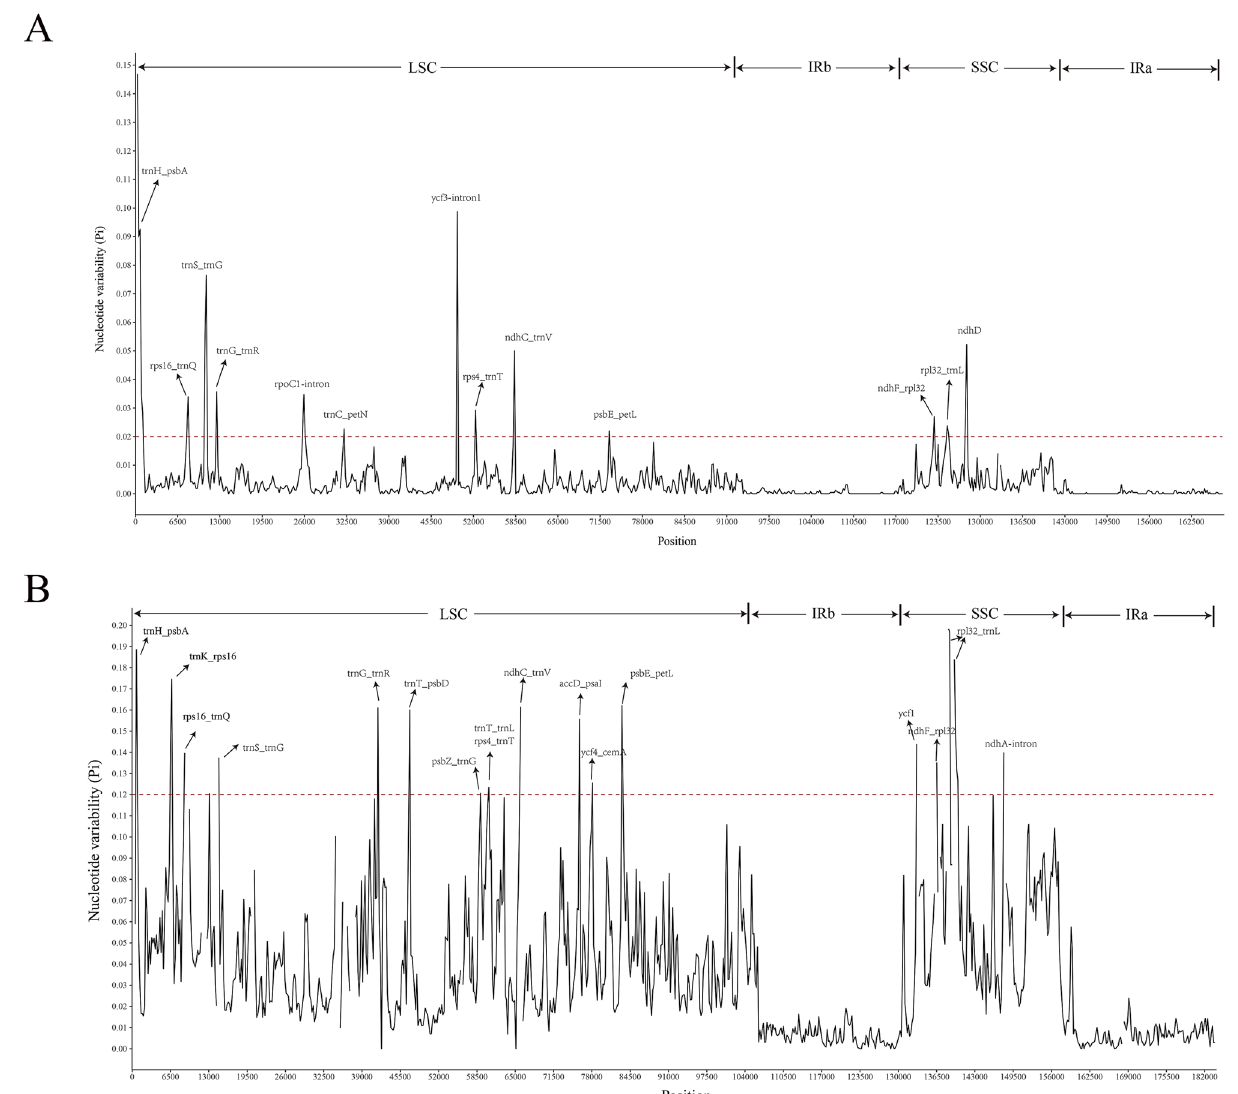
Figure 9. Nucleotide variability (pi) values of 15 Umlus species and 23 Ulmaceae species. ( A ): pi values of 15 Umlus species. ( B ): pi values of 23 Ulmaceae species. X-axis: name of the regions; Y-axis: nucleotide diversity. window length: 300 bp; step size: 200 bp.